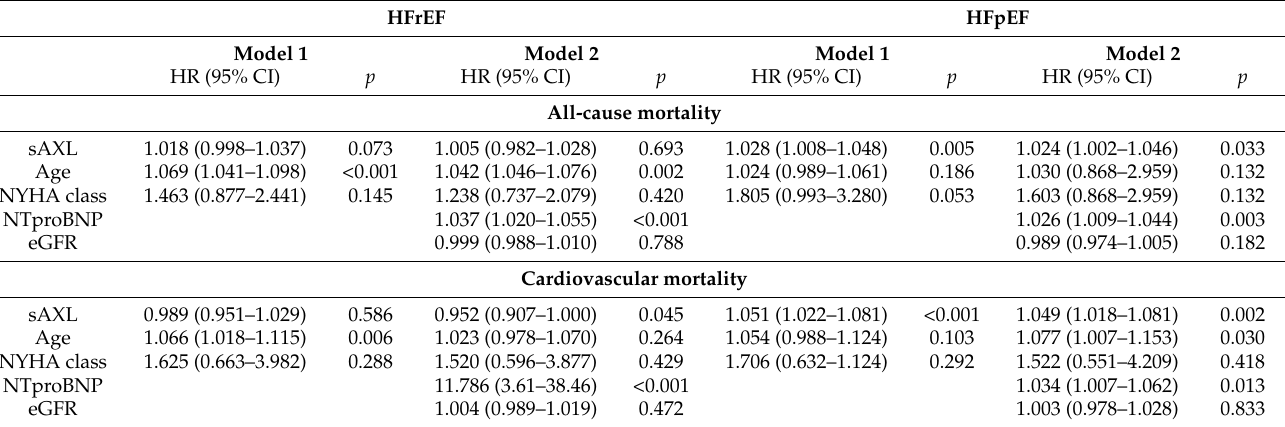
Table 3. Multivariable Cox regression value for absolute sAXL.